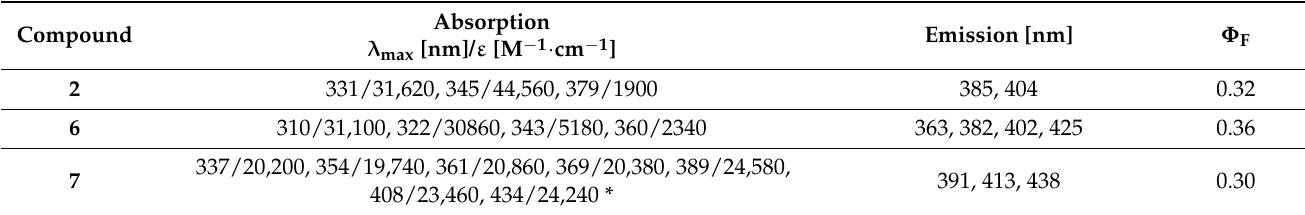
Table 1. Photophysical data of compounds 2 , 6 and 7 .